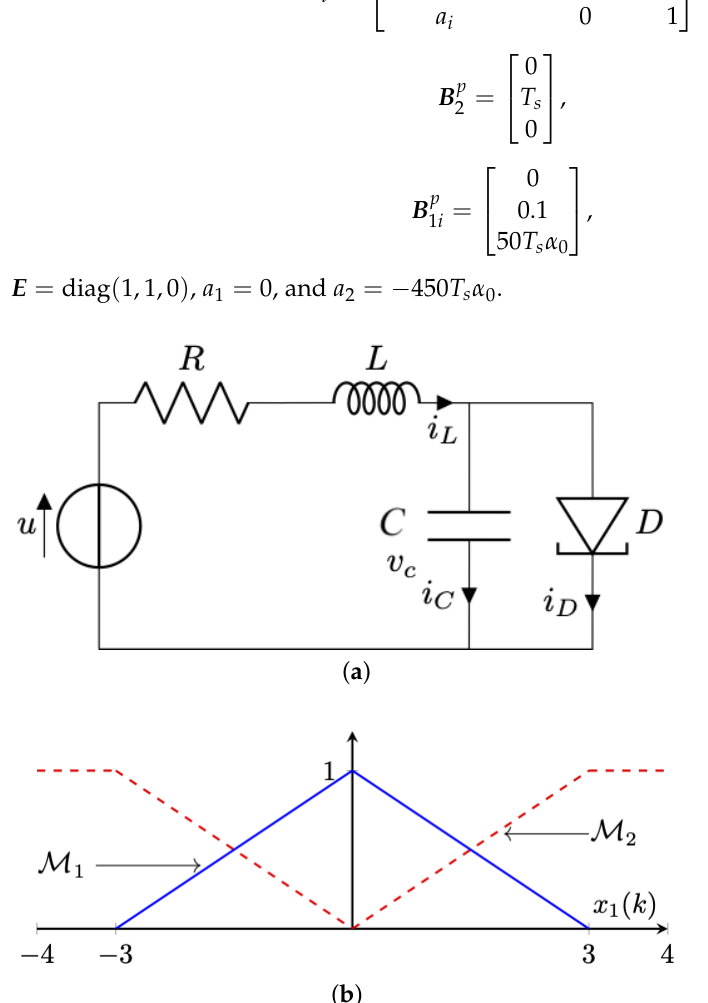
Figure 5. Tunnel diode circuit, where C is a capacitor, D is a diode, L is an inductor, R is a resistor, v C ( k ) = x 1 ( k ) , and i L ( k ) = x 2 ( k ) ( a ); and membership functions ( M j , for j ∈ { 1,2 } ) for the two fuzzy sets ( b